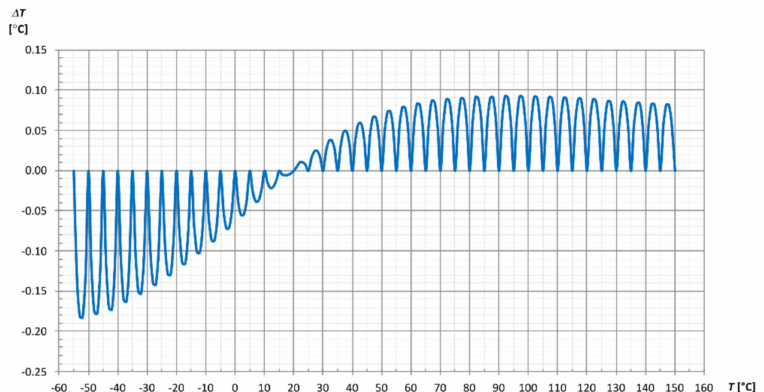
Figure 7. Temperature error with look-up table and linear